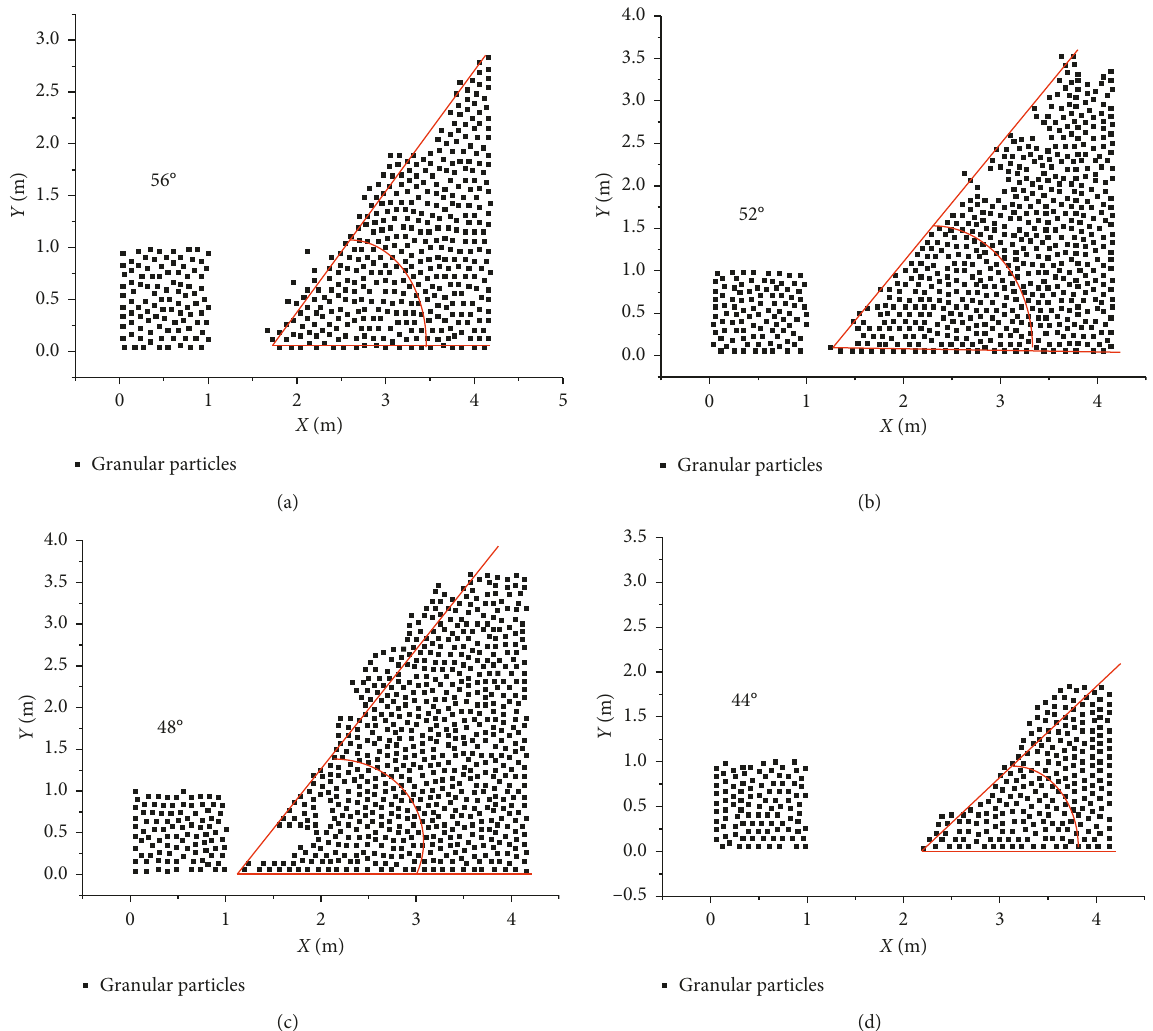
Figure 14: The relationship between the natural repose angle and the slip surface. (a) The 46 ° natural repose angle. (b) The 36 ° natural repose angle. (c) The 26 ° natural repose angle. (d) The 16 ° natural repose